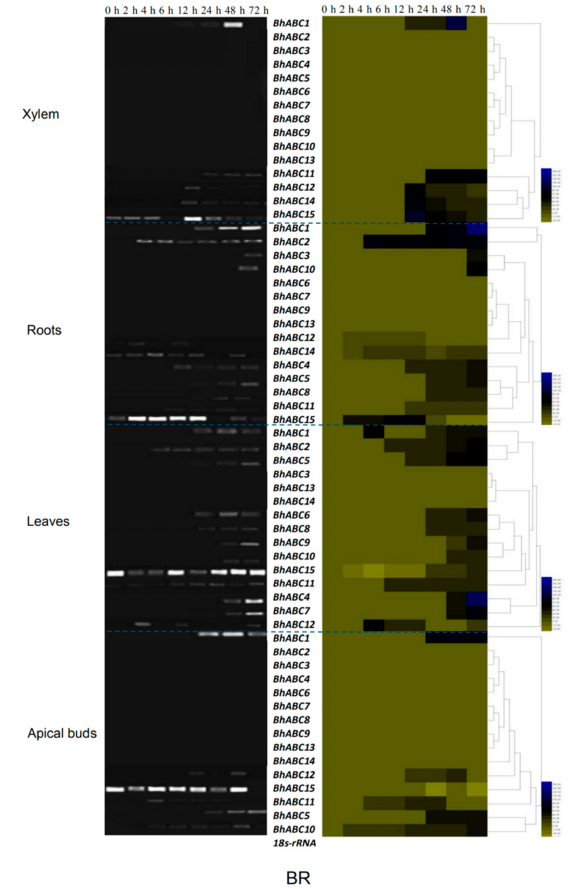
Figure 4. Expression patterns of BhABC genes in xylem, roots, leaves, and apical buds after BR treatment. Heat map showing responses of BhABC genes to BR (right); semi-quantitative RT-PCR analysis with 18s RNA internal reference